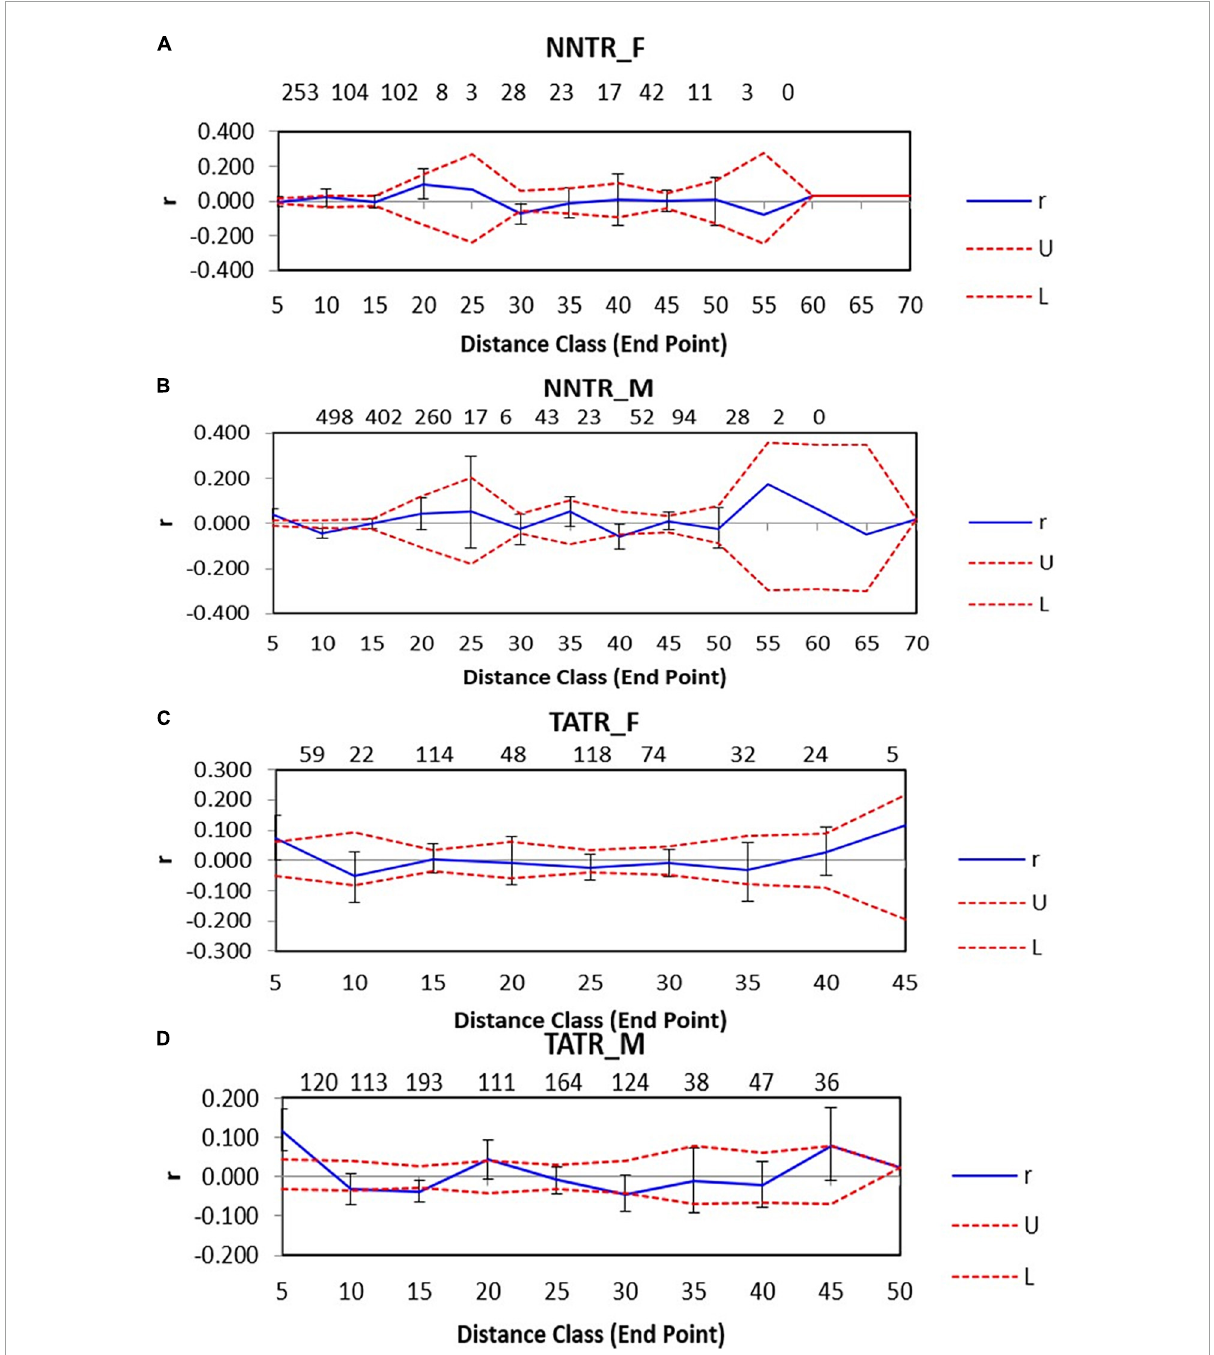
FIGURE3 Spatial genetic structure correlograms for the two dhole populations Nawegaon-Nagzira Tiger Reserve (NNTR) and Tadoba-Andhari Tiger Reserve (TATR). The sample size at each distance class is provided above each correlogram. Spatial genetic structure correlograms for (A) NNTR females; (B) NNTR males; (C) TATR females; (D) TATR